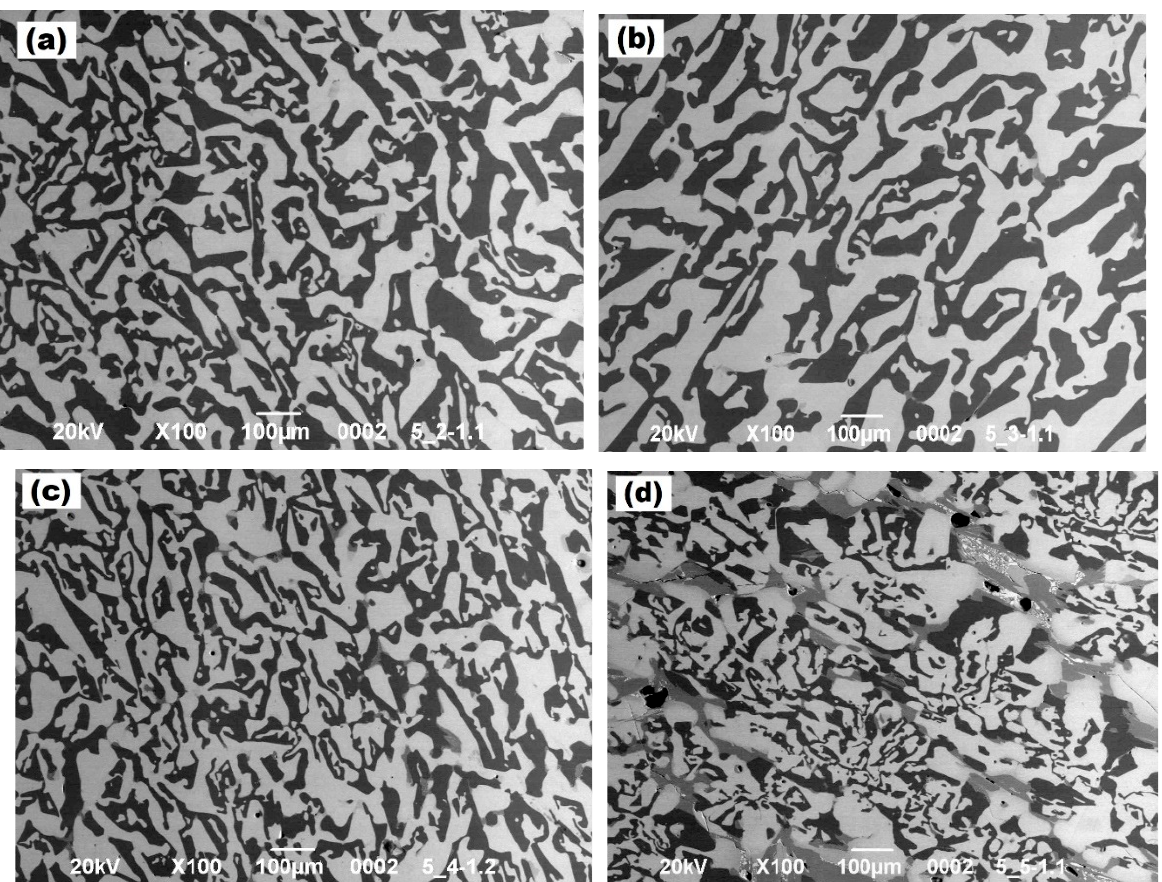
Figure 2. SEM images of the (Al 2 O 3 -YAG):Ce eutectic: ( a ) sample 2, ( b ) sample 3, ( c ) sample 4, and ( d ) sample 5.